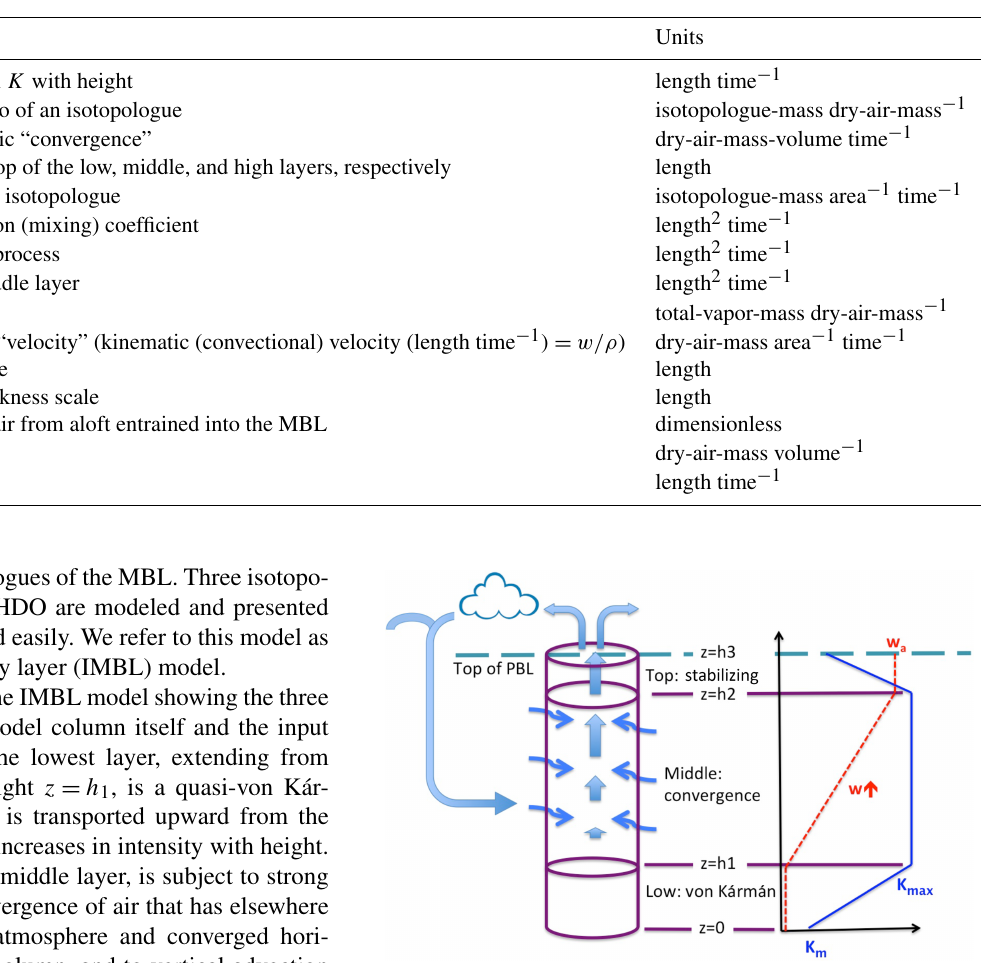
Table 1. Symbols used.